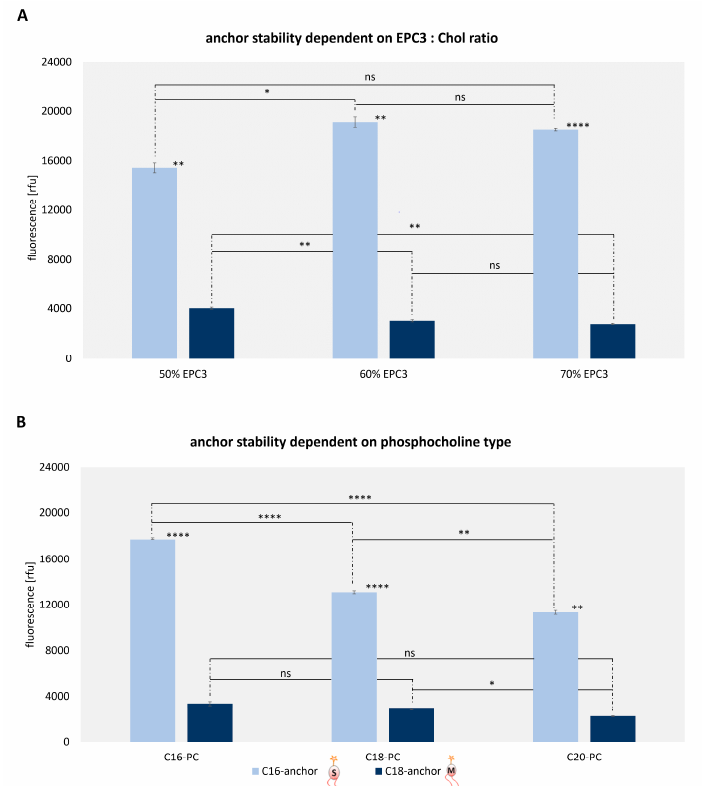
Figure 4. Quantification of lipid exchange depending on ( A ) the EPC3: Chol (cholesterol) ratio ( B ) and on the carbon atom number of phosphocholines used for liposome preparation. 1.0 × 10 5 UKRV Mel-15a cells were incubated with 5 vol-% atto 488 linked liposomes and cytochalasin D at 37 °C and fixed with a 4% formaldehyde solution before flow cytometric analysis. The significance between two values is illustrated by * p = 0.05–0.01, ** p < 0.001, **** p > 0.0001 and ns = no significance. The statistically significant was calculated using the Welch and Brown–Forsythe version of the one-way ANOVA test.